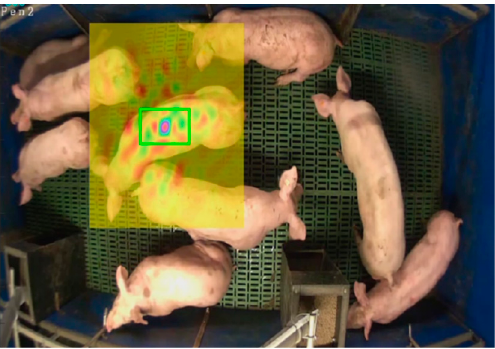
Figure 4. The tracking target (green box) in our method and its search area (yellow box).